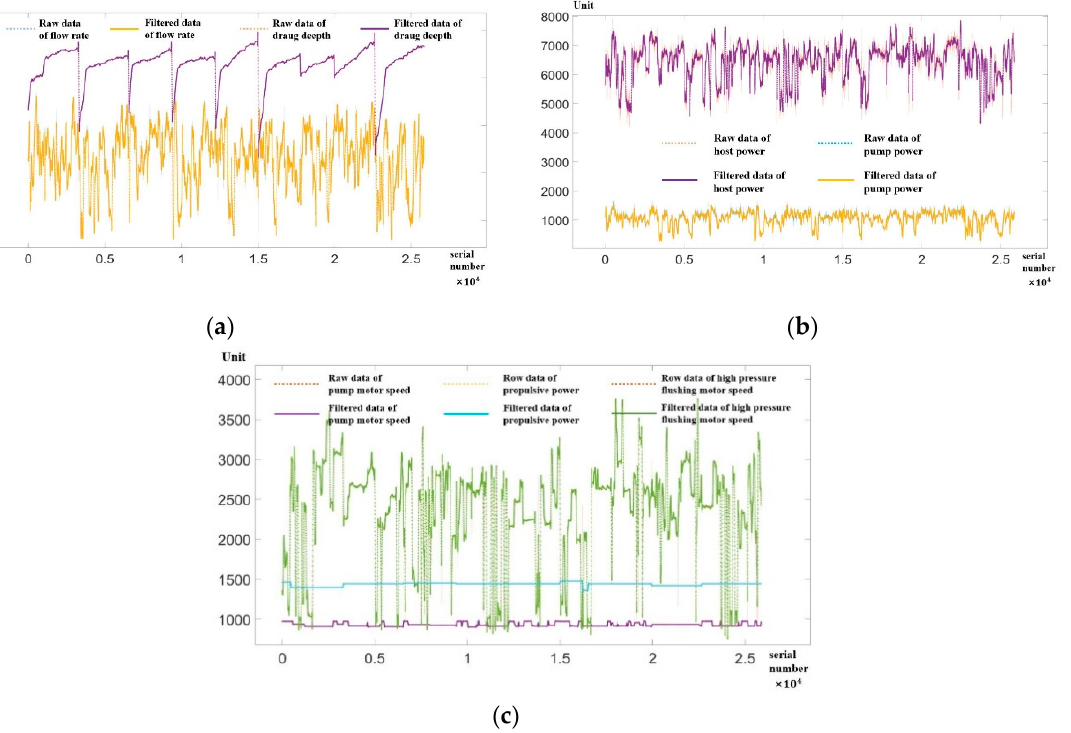
Figure 3. Filtering of key parameters of TSHD: ( a ) the comparison of the two sets of characteristic quantities of the flow rate and the drag depth before and after filtering; ( b ) the comparison of the two sets of characteristic quantities of the pump power and the host power before and after the filtering; ( c ) the comparison of the three sets of characteristic quantities of the pump motor speed, the propulsion power and the high pressure flushing motor speed before and after filtering